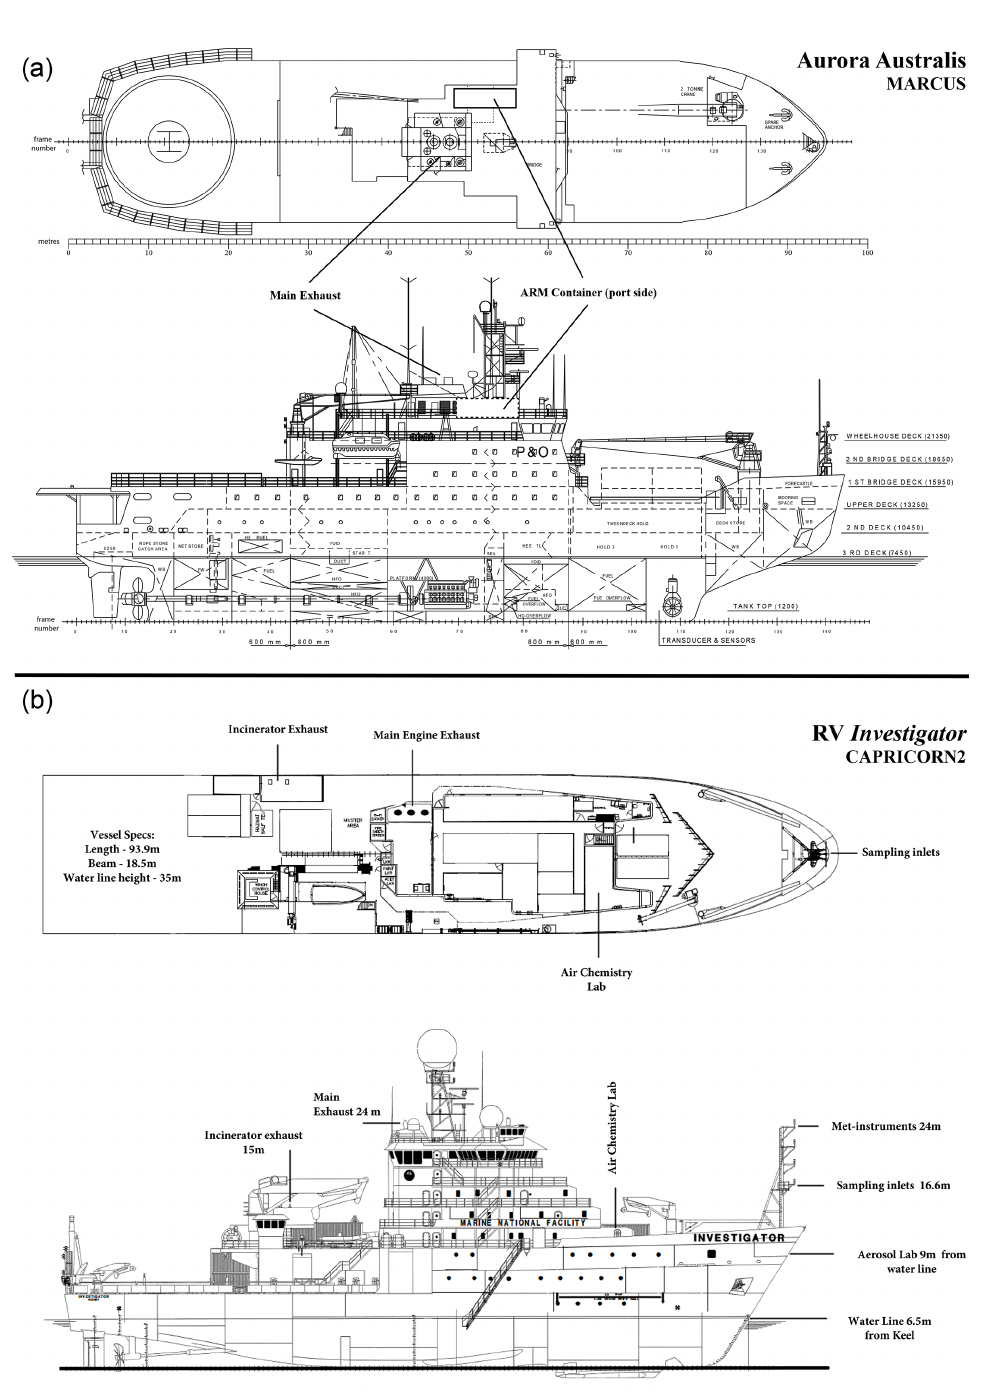
Figure A1. Ship schematics of both the Aurora Australis (a) , used for the MARCUS campaign, and the RV Investigator (b) , used for the CAPRICORN2 campaign. Contamination of samples by the ship’s own exhaust is the primary driver in the removal of data, with only 11% (500h) and 86% (760h) of data remaining after exhaust filtering for MARCUS and CAPRICORN2 campaigns, respectively. Exhaust contamination is driven by the proximity of the measurements to the exhaust, the age and cleanliness of the engine, together with ship operations during voyages and whether these operations align the ship with favourable wind directions that push the exhaust away from the sampling inlet. All these factors contributed to the high contamination of MARCUS data relative to CAPRICORN2